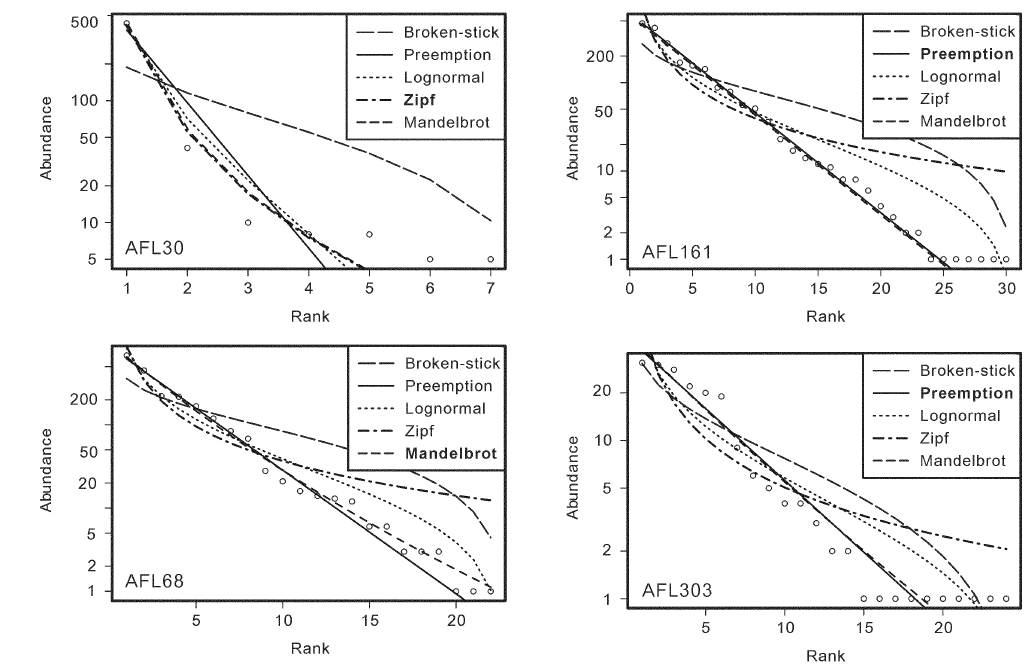
Fig. 1. Species-abundance distribution and fitting curves of five models for four collections of the Cathaysiorthis fauna of southeast China. Circles represent ranked abundance data; the best fit for each sample is shown by a bold